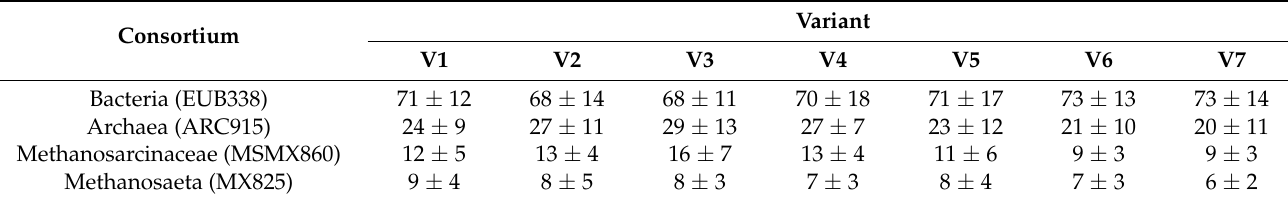
Figure 6. One-time CH 4 production efficiency. Table 3. Microbial taxonomy in AS depends on the experimental variant.